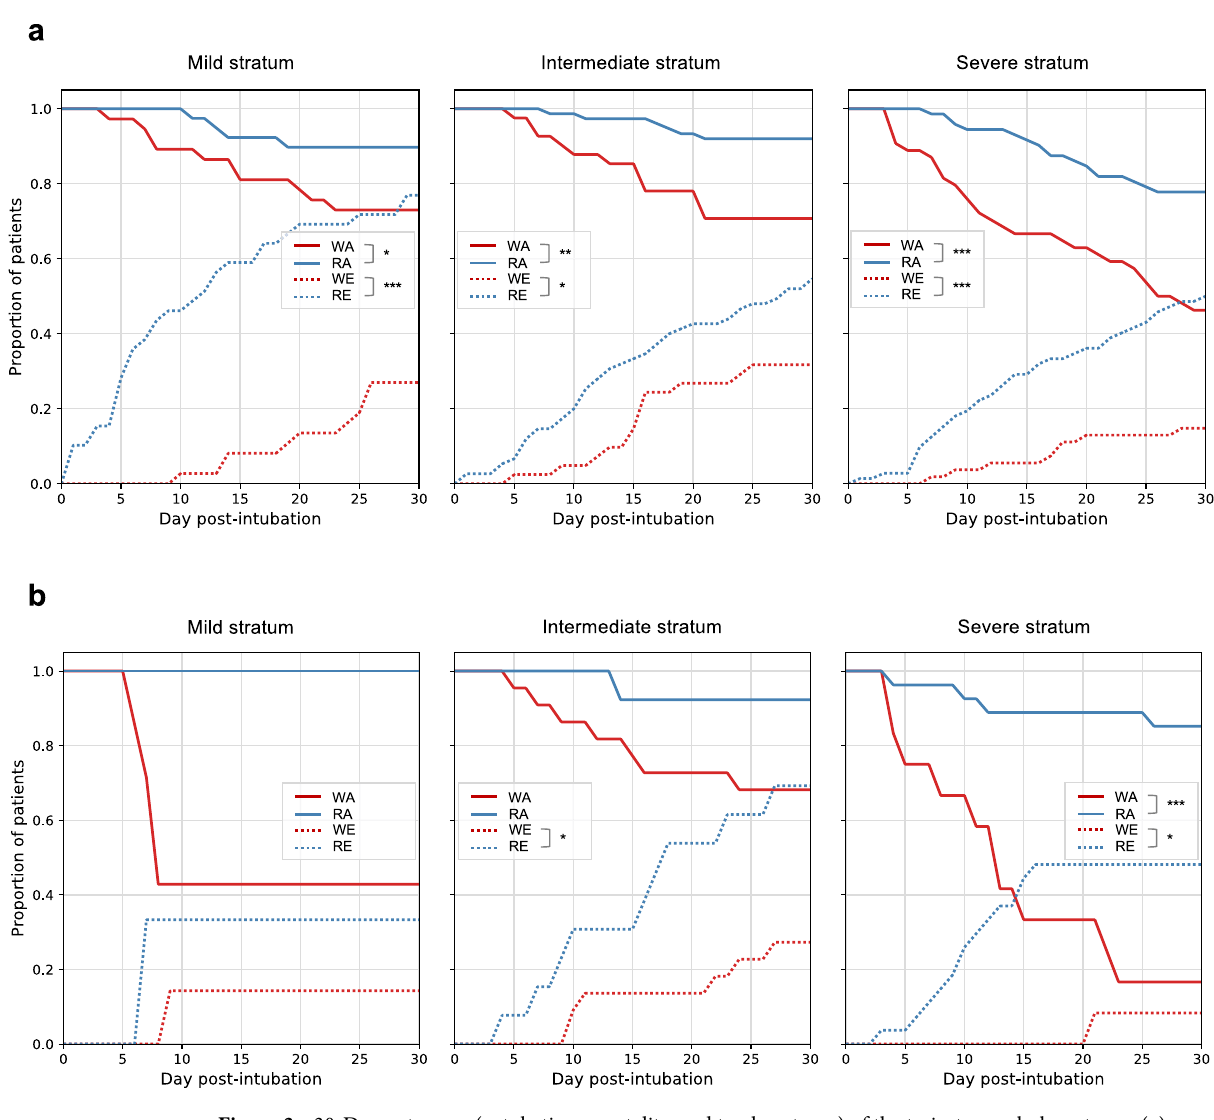
Figure 3. 30-Day outcomes (extubation, mortality, and tracheostomy) of the trajectory subphenotypes. ( a ) 30-day outcomes of subphenotypes derived in NYP-WCMC cohort. ( b ) 30-day outcomes of subphenotypes derived in NYP-LMH validation cohort. Chi-square/Fisher’s exact tests were applied to compare 30-day outcomes between the worsening and recovering subphenotypes for each baseline strata. *Denoting testing significance passed p-value < 0.05; **denoting testing significance passed p-value < 0.01; ***denoting testing significance passed p-value < 0.001. WA worsening subphenotype alive, RA recovering subphenotype alive, WE worsening subphenotype extubated, RE recovering subphenotype